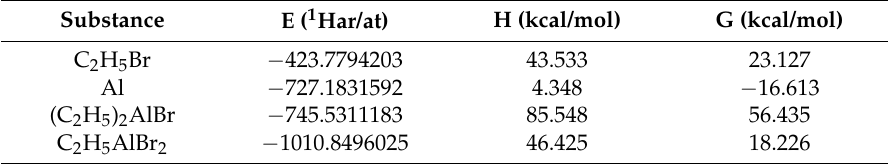
Figure 3. The relationship between the thermodynamic properties of C 2 H 5 Br and temperature. Table 1. The total energy and the thermodynamic properties at 298.15 K of each component. Substance E ( 1